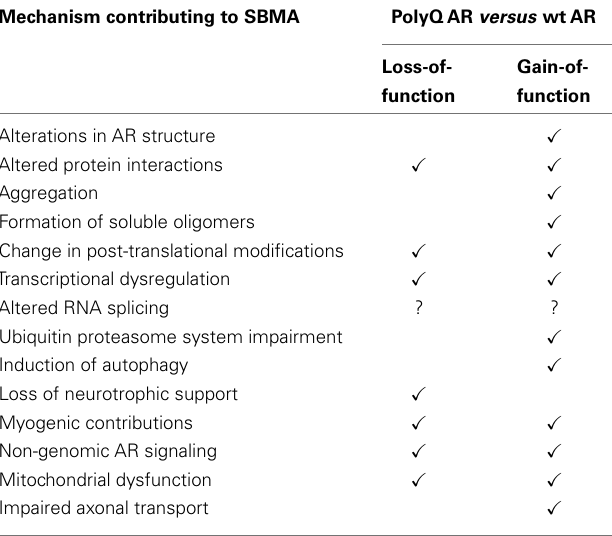
Table 2 | PolyQAR loss- and gain-of-function mechanisms in